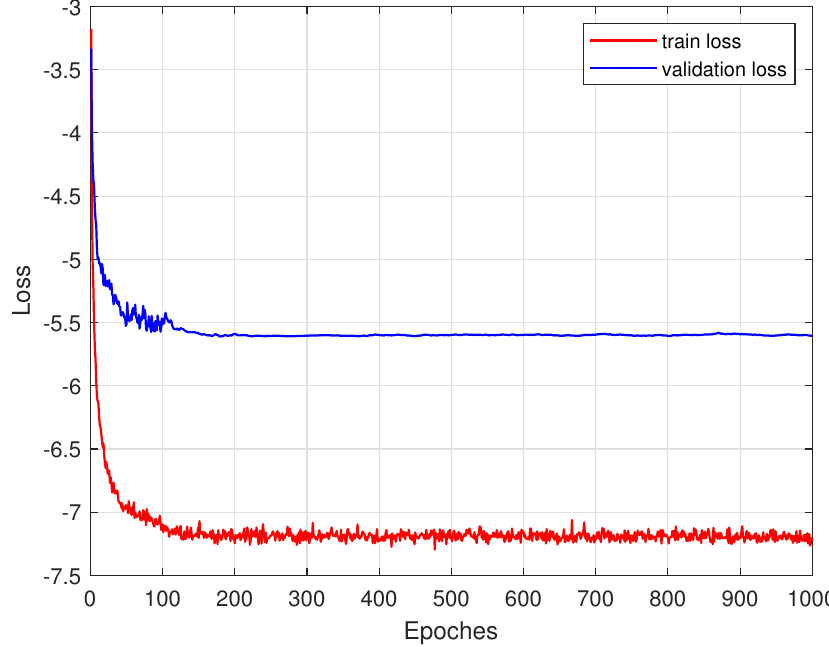
Figure 6. Convergence performance of the proposed scheme in geometric mmWave channel with N t = 64.